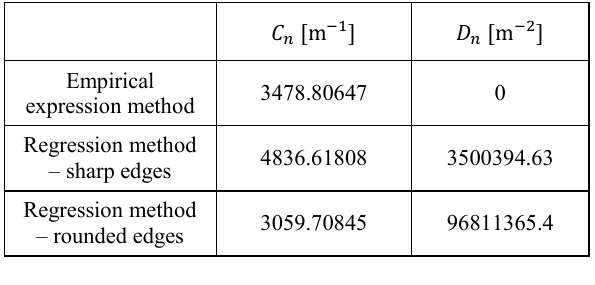
Table 1. Evaluated inertial and viscous loss coefficients in the direction normal to the plate from different methods.